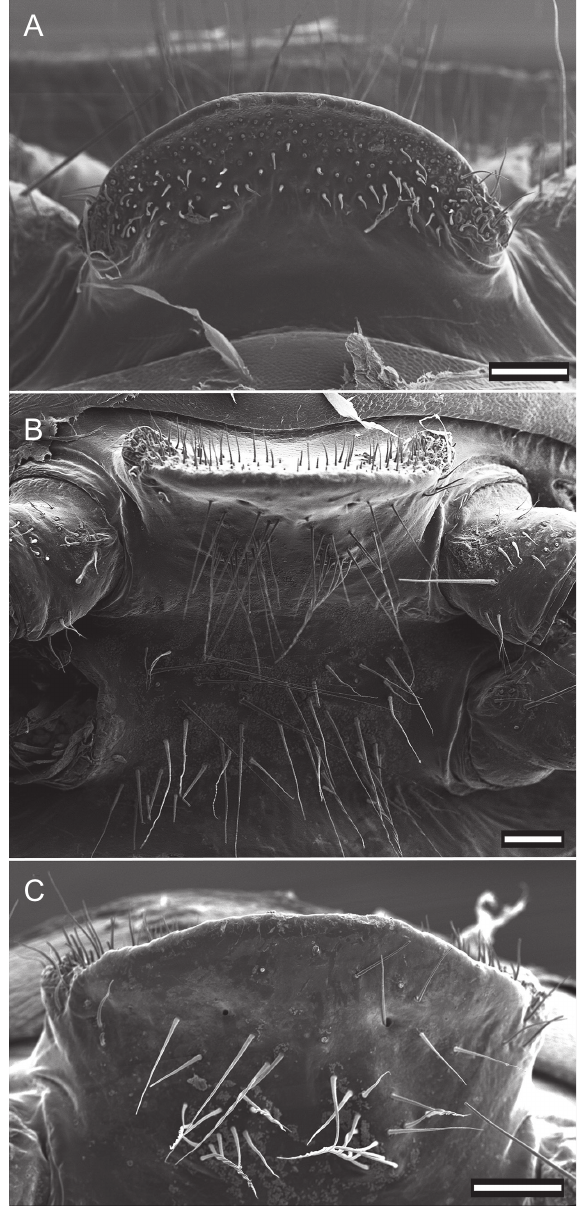
Fig. 3. Male sternite lamella on ring 5 of Pogonosternum nigrovirgatum (Carl, 1902) (NMV K-12158). A . Anterior view. B . Ventral view. C . Posterior view. Scale bars: 0.1